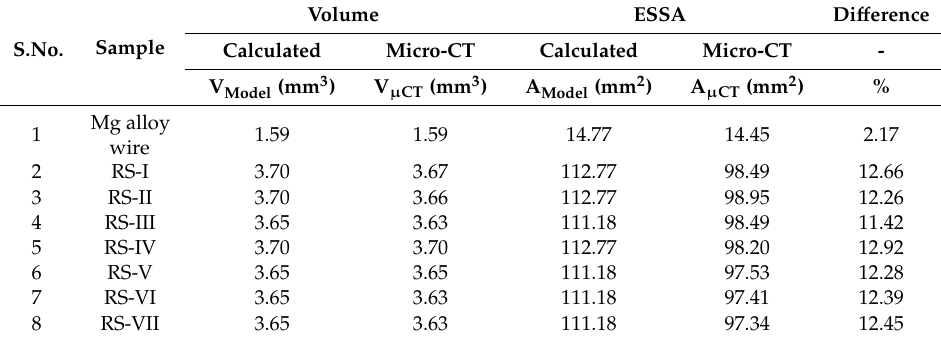
Table 2. Validation of the calculated surface area with micro-CT